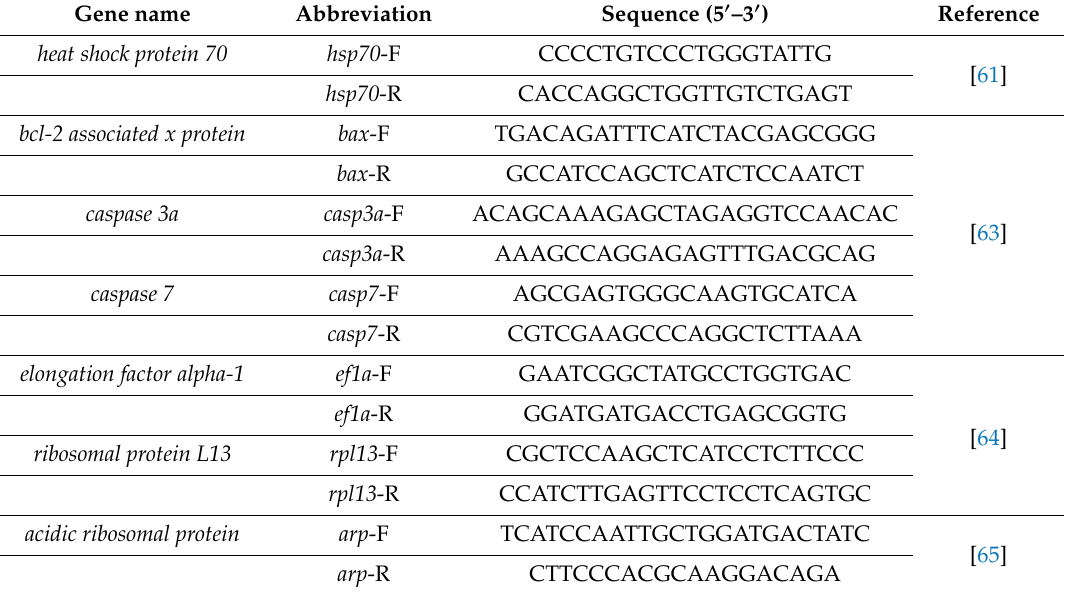
Figure S2: Skin morphology scores of salmon exposed to di ff erent ozone